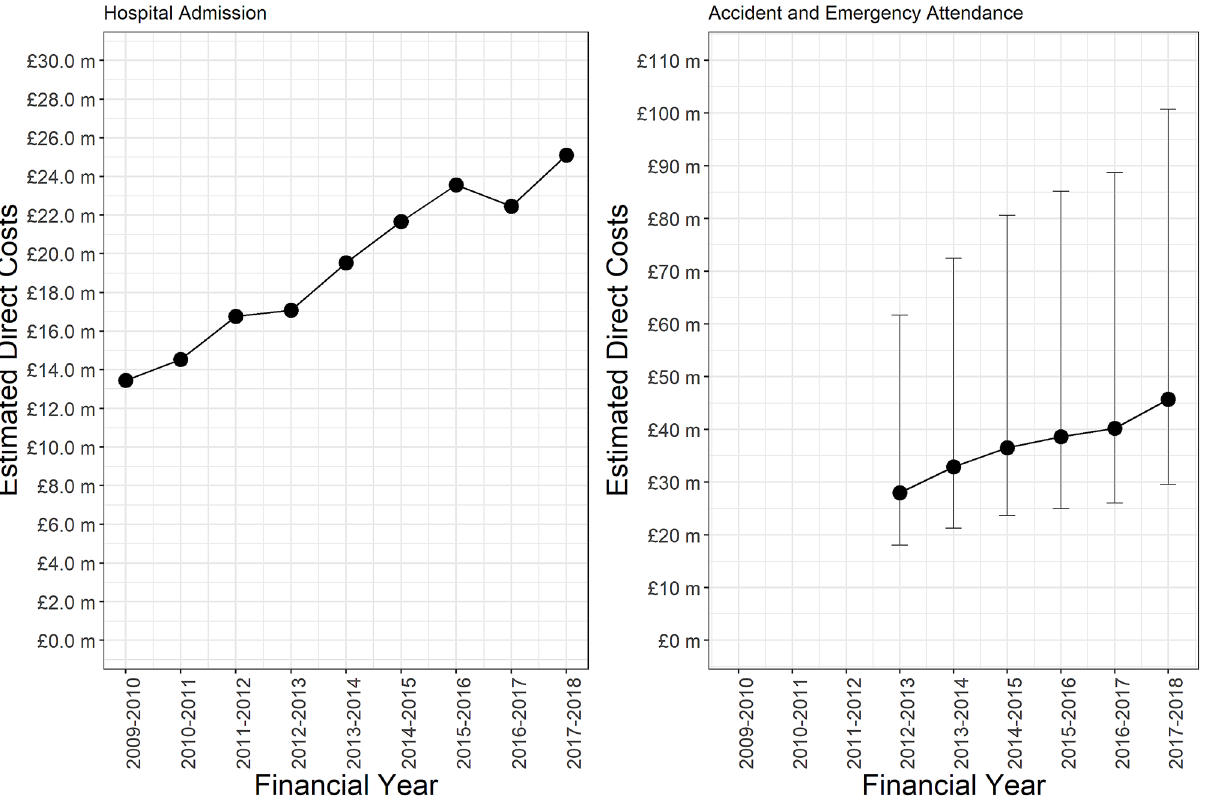
Figure 3. Estimated direct health care costs of dog bite hospital admissions and accident and emergence attendance in